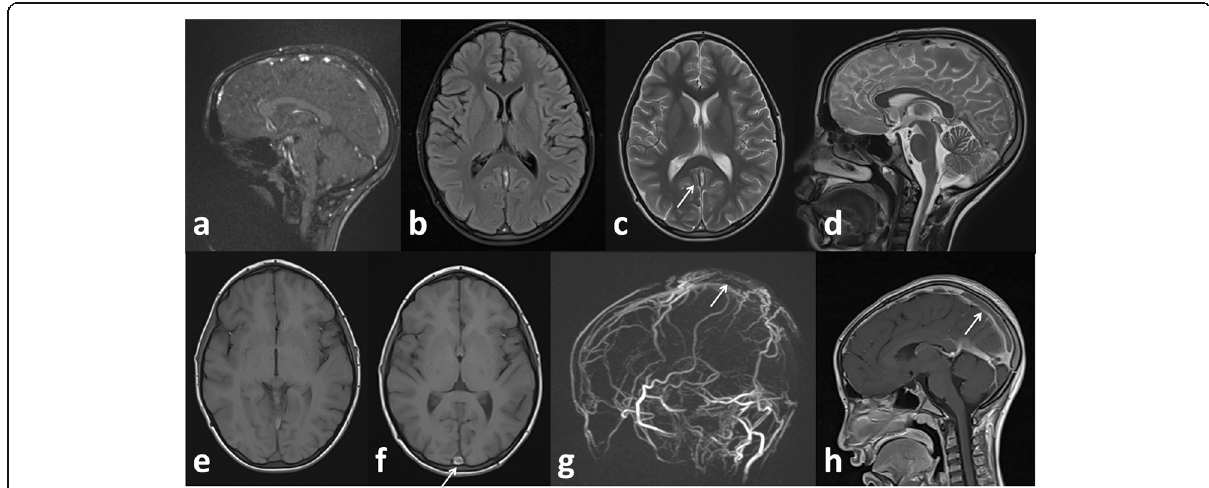
Fig. 9 Female patient 42 years old. Superior sagittal sinus thrombosis (white arrows in c , f ), filling defect in MRV (white arrow in g ) and post contrast image (white arrow in h )